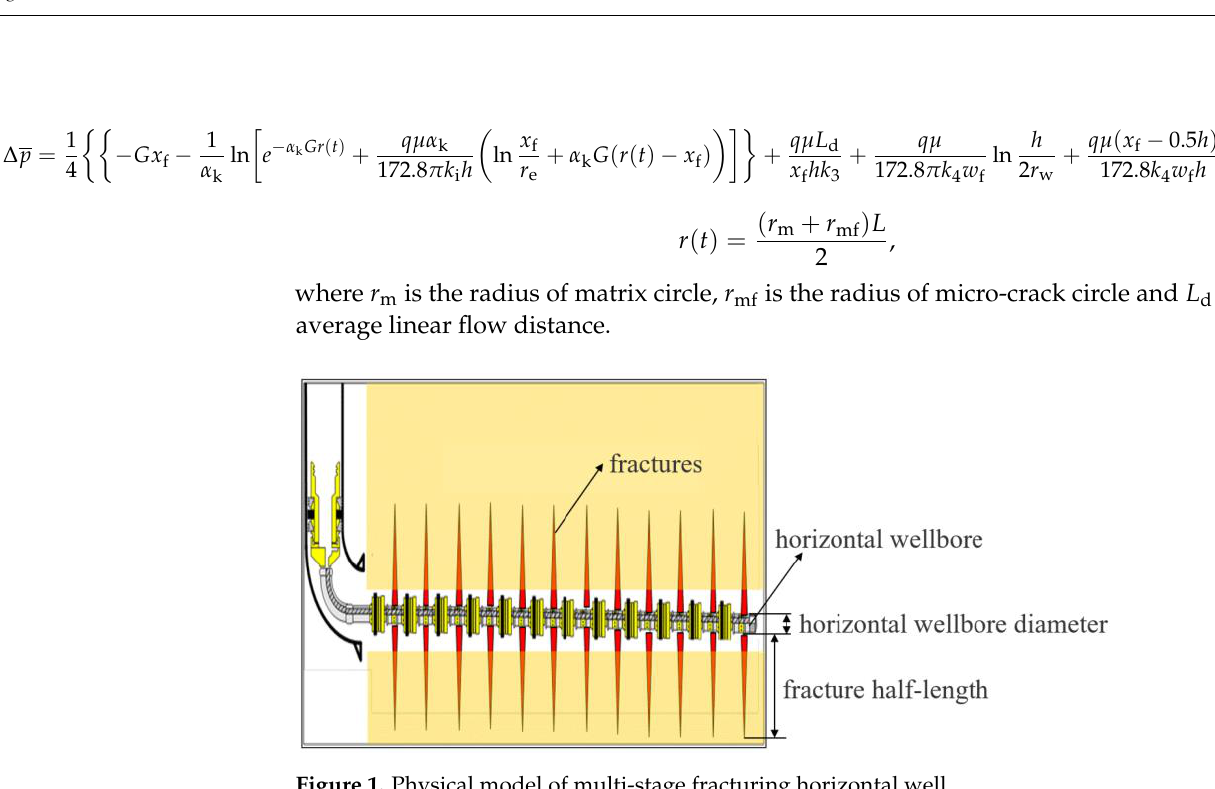
Figure 1. Physical model of multi-stage fracturing horizontal well.